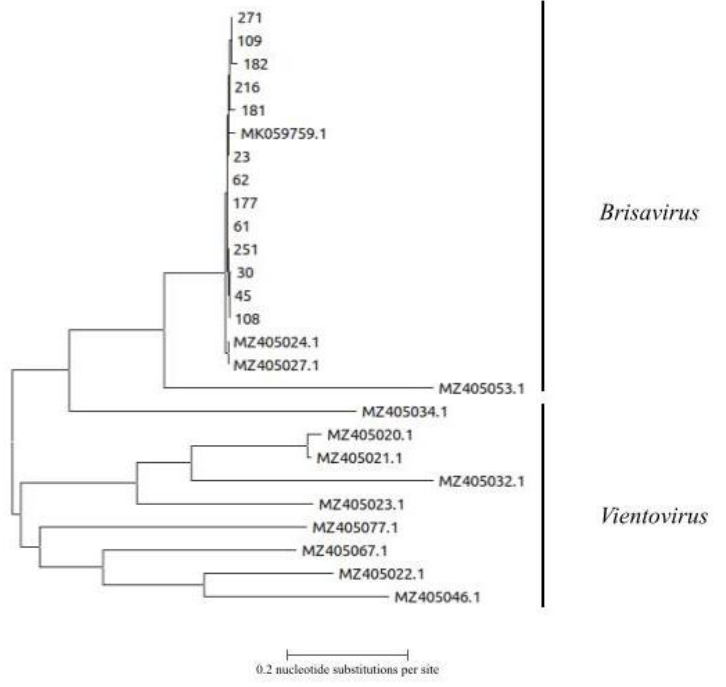
Figure 2. Phylogenetic analysis of 13 ReDoV sequences from the present study. The nt tree is based on a fragment of 477 base from the Rep gene of the genome viral genome. ReDoV sequences from the present study are indicated by numbers. The 13 sequences of ReDoV obtained from GenBank are indicated by accession number. Clades representing the two Redondovirus genera are indicated. The bar represents the number of substitutions per site.